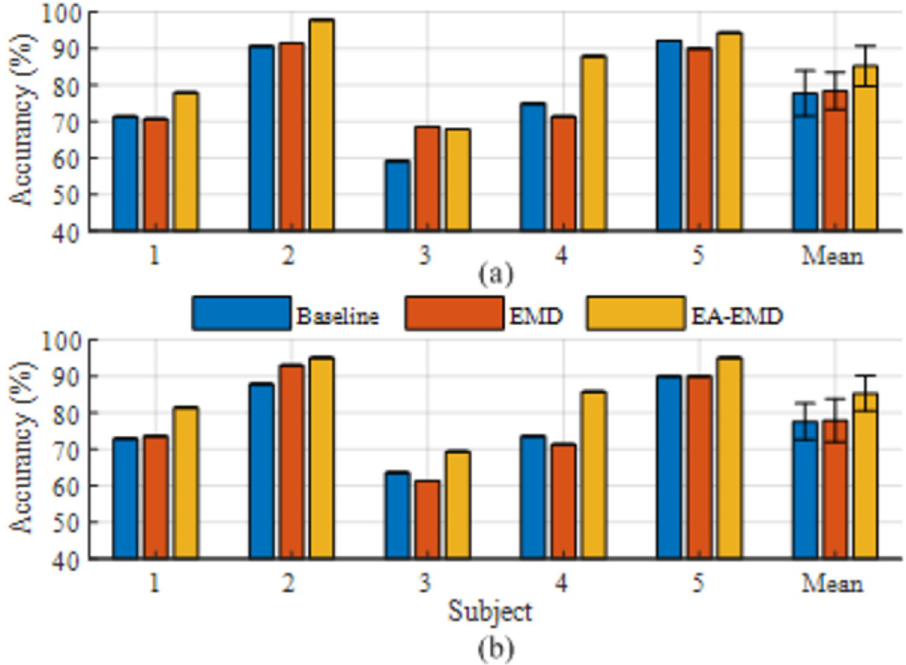
Fig 8. Classification accuracies of the five subjects in data set 2 achieved by 20 training trails per class using (a) LDA and (b) LR as the classifier. The error bars represent standard errors.